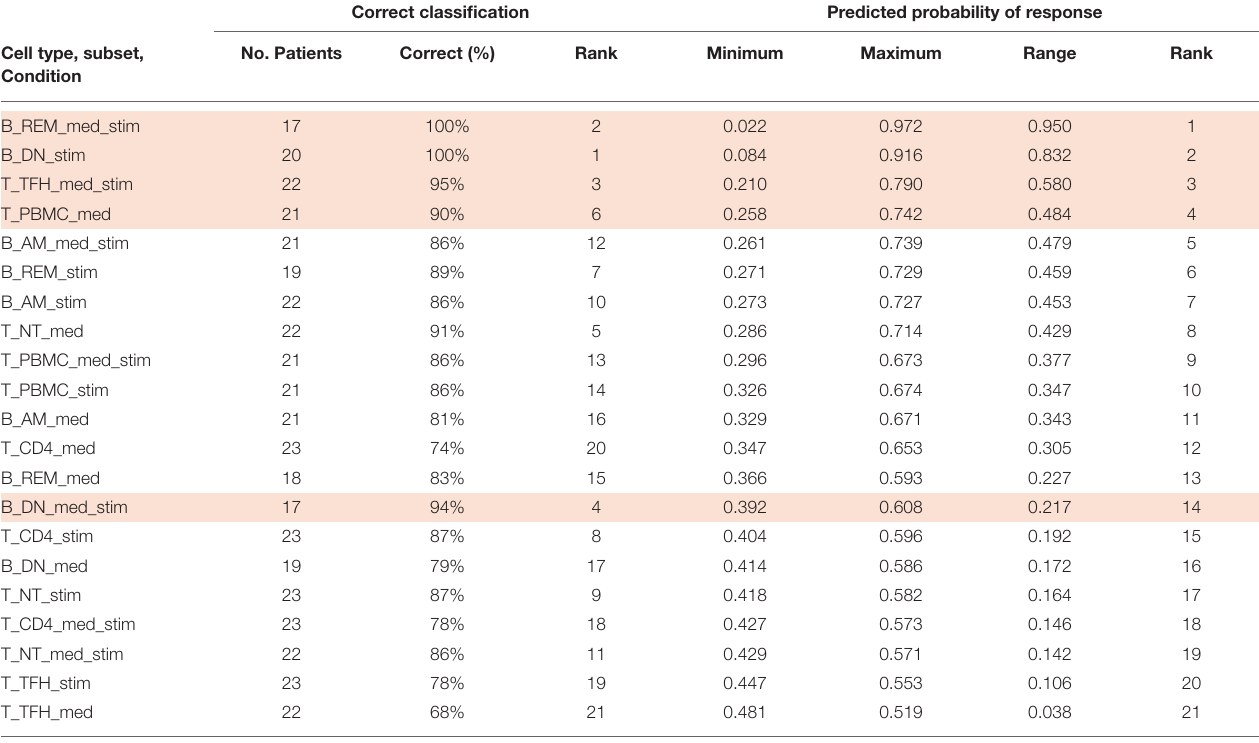
TABLE 3 | Subsets and conditions importance ranking. Correct classification Predicted probability of response Cell type, subset,